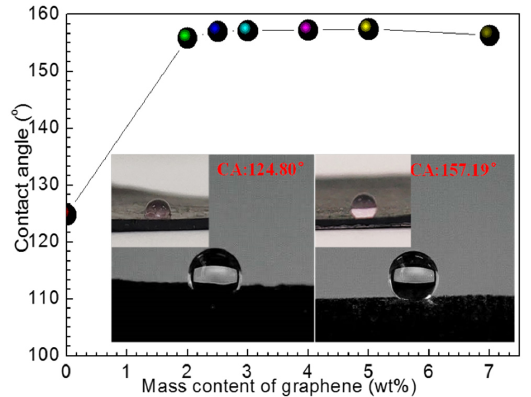
Figure 9. Water contact angle of RGO / NCC-TPU conductive films with di ff erent mass contents of RGO. The insets are photos of the water contact angle of the pure TPU and the composite film with 4 wt% of RGO.